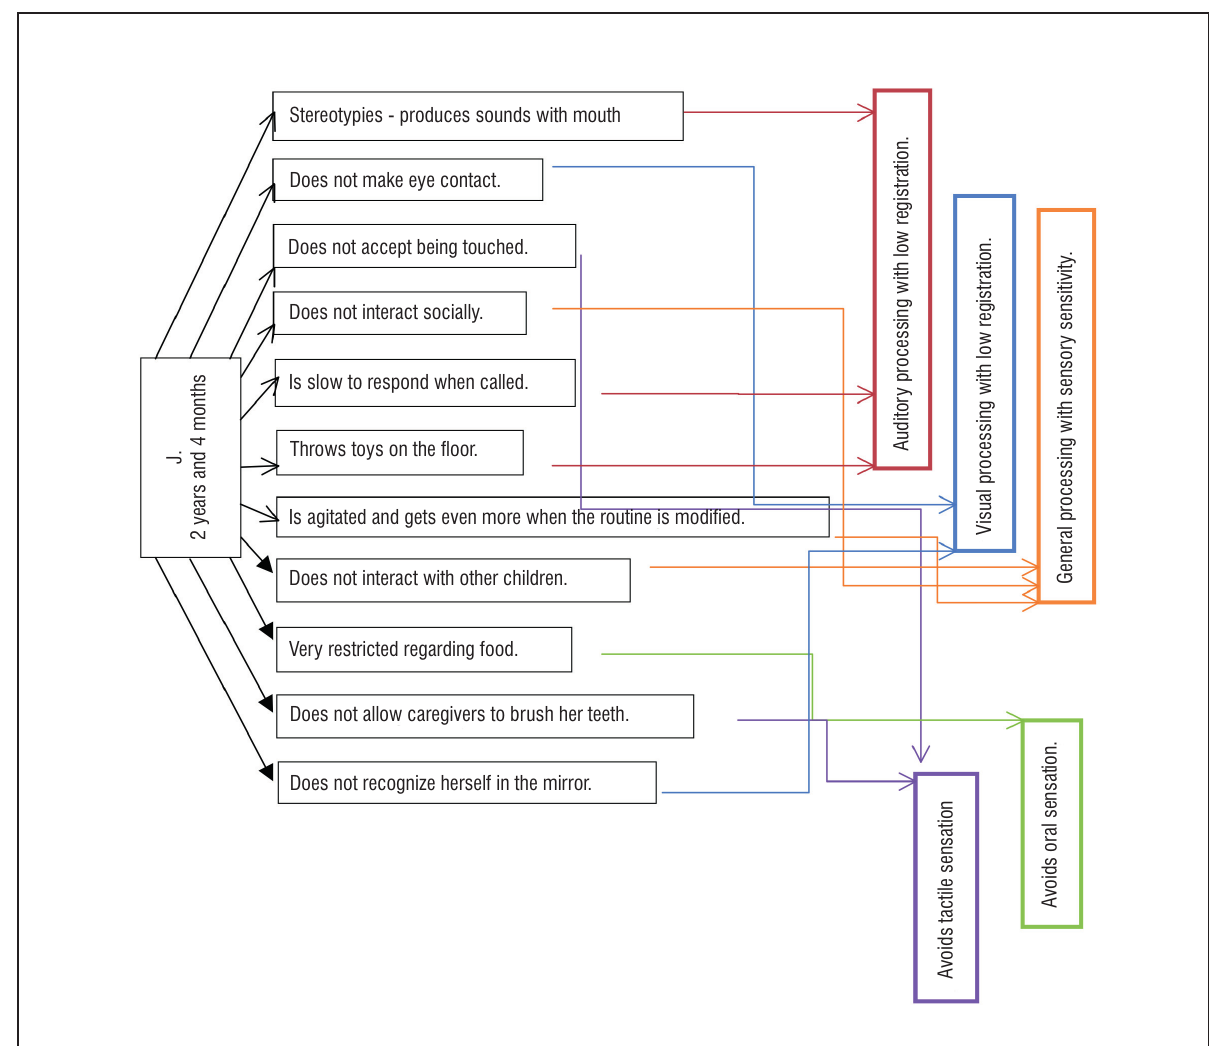
Figure 5 - Decision structure of the explanatory hypothetical